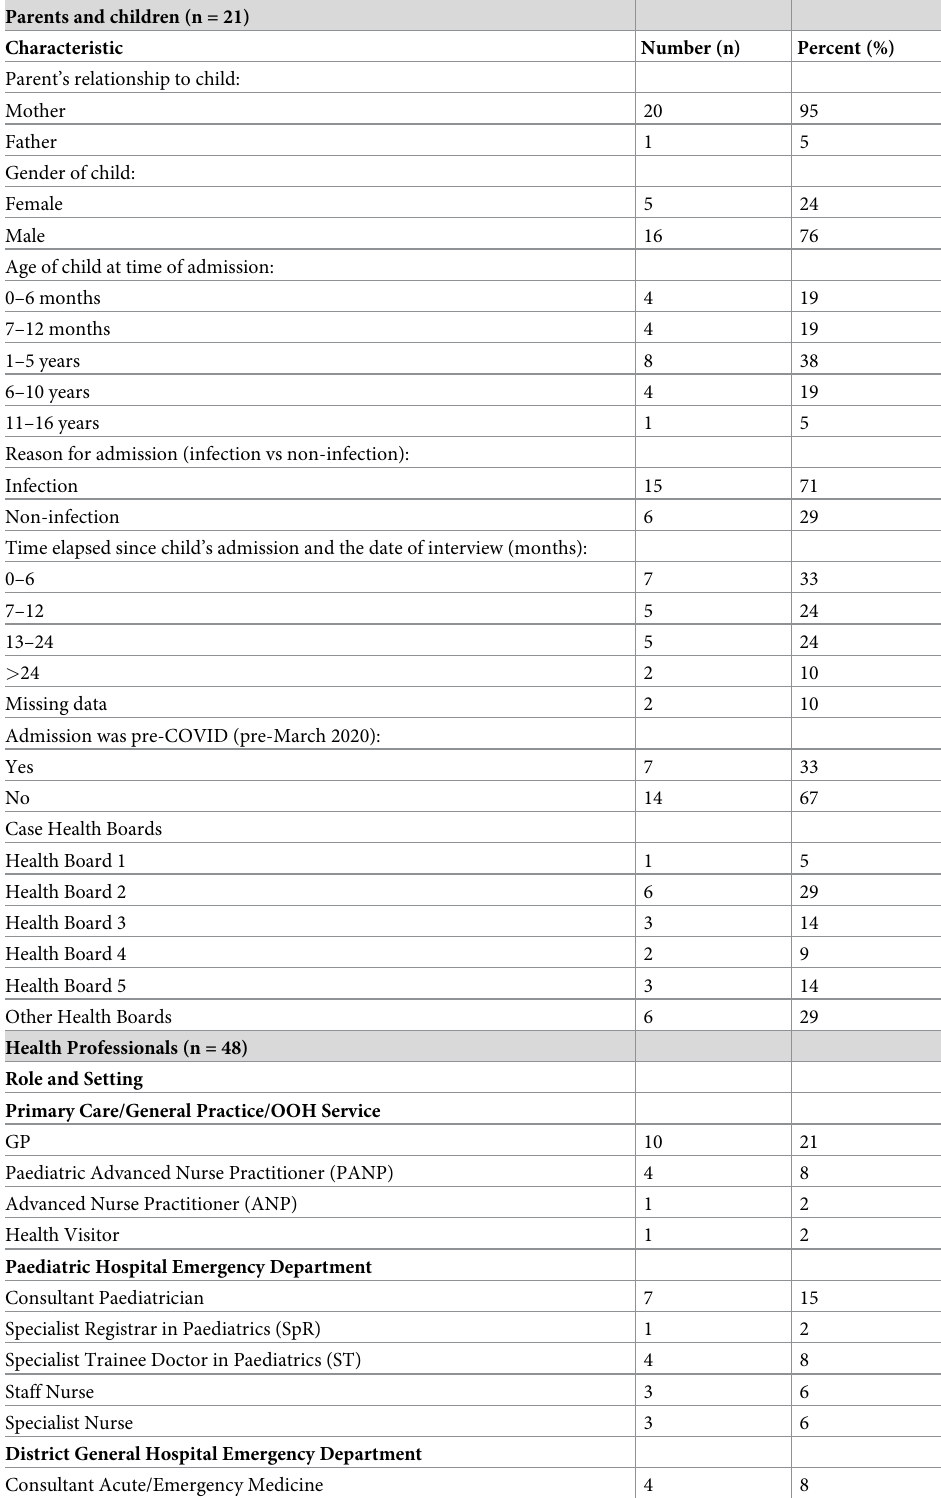
Table 1. Characteristics of participants (n =